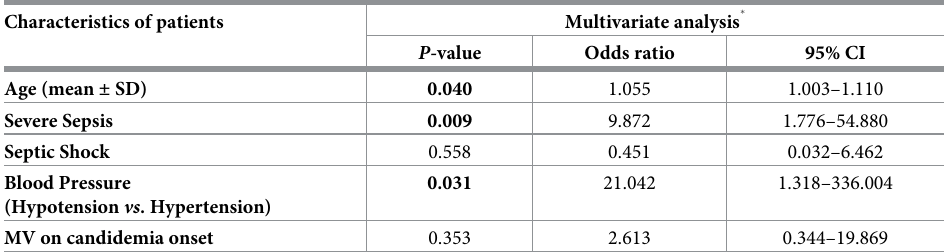
Table 6. Multivariate logistic regression analysis of risk factors for 30-day mortality. Characteristics of